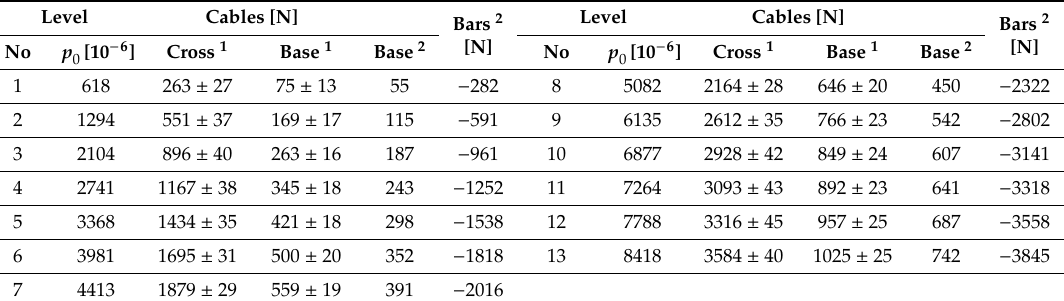
Table 3. Member forces for the each prestress level.